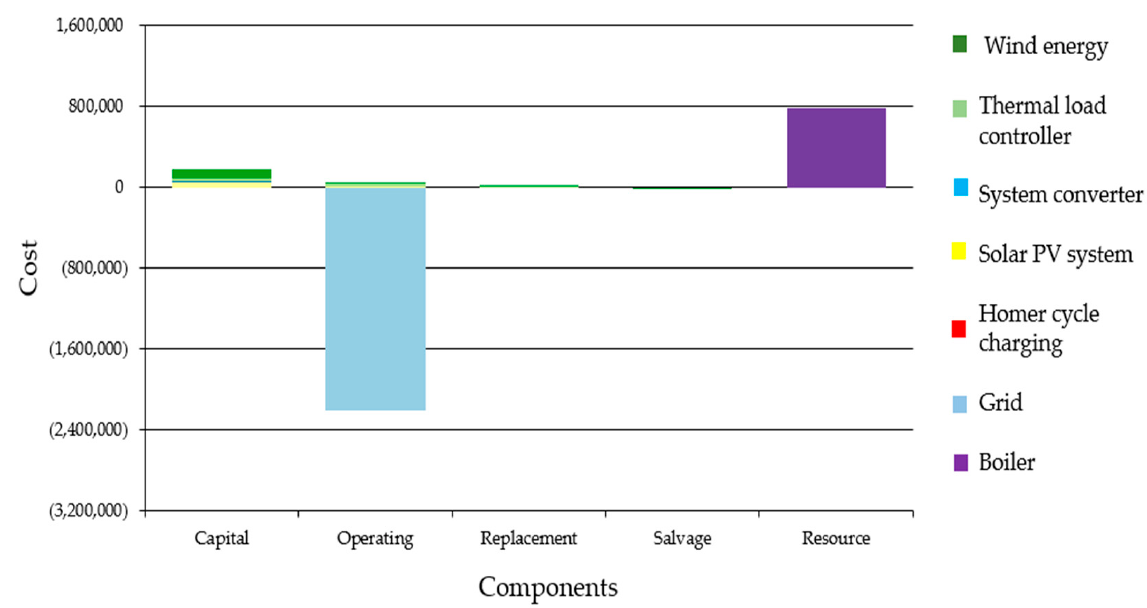
Figure 13. Total cost of proposed system and resources values of the project.